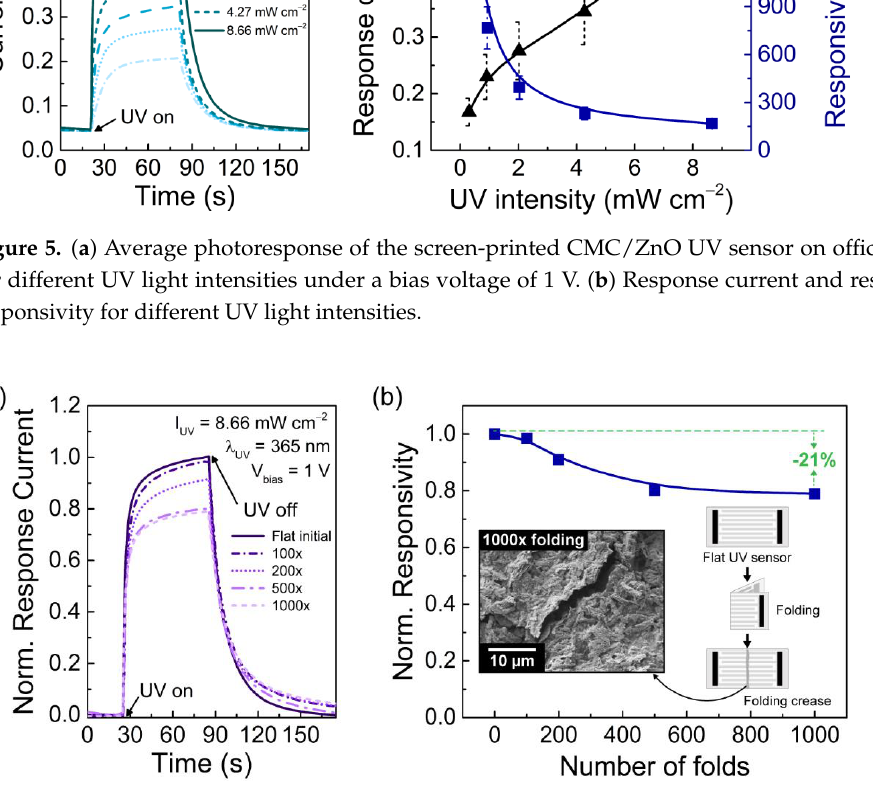
Figure 6. ( a ) Comparison of the normalized response current of a single screen-printed ZnO UV sensor in a flat position before and after being folded up to 1000 successive times. ( b ) Normalized responsivity of the UV sensor as a function of the number of folds. Inset of an illustration of the folding process and an SEM image showing the resulting cracks in the folding crease line of the sensor after being folded 1000 consecutive